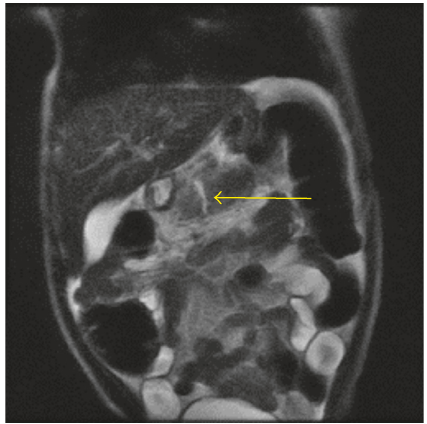
Figure 1: CT of abdomen showing linear low attenuation within the pancreatic body.